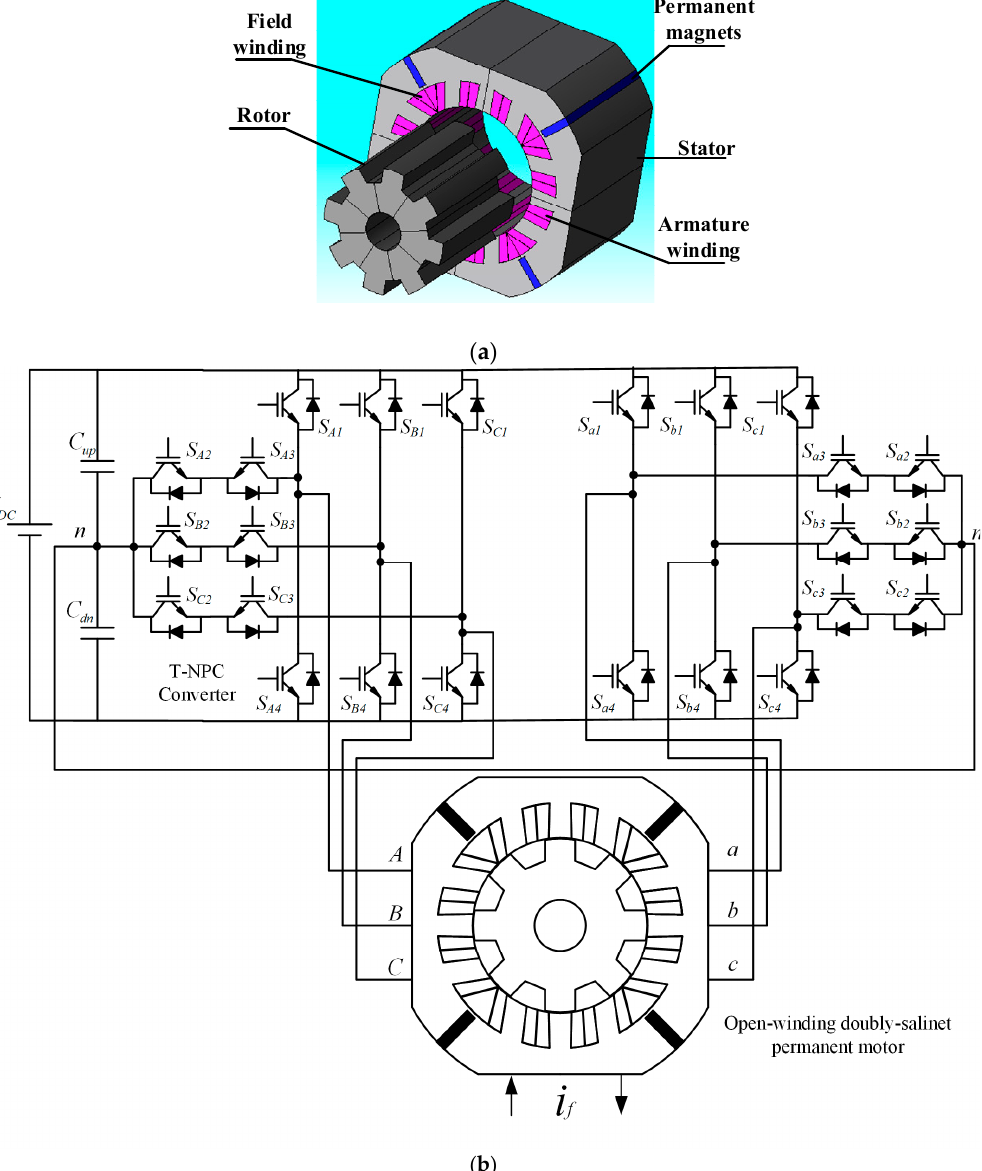
Figure 1. Structure of DSPM and proposed drive system. ( a ) 3D Views of DSPM. ( b ) System configuration.